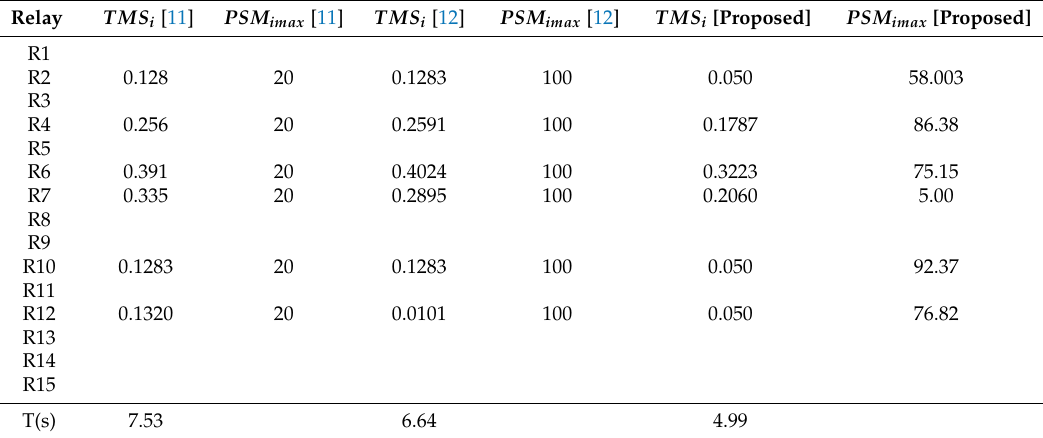
Table 3. Coordination parameters for OM1.